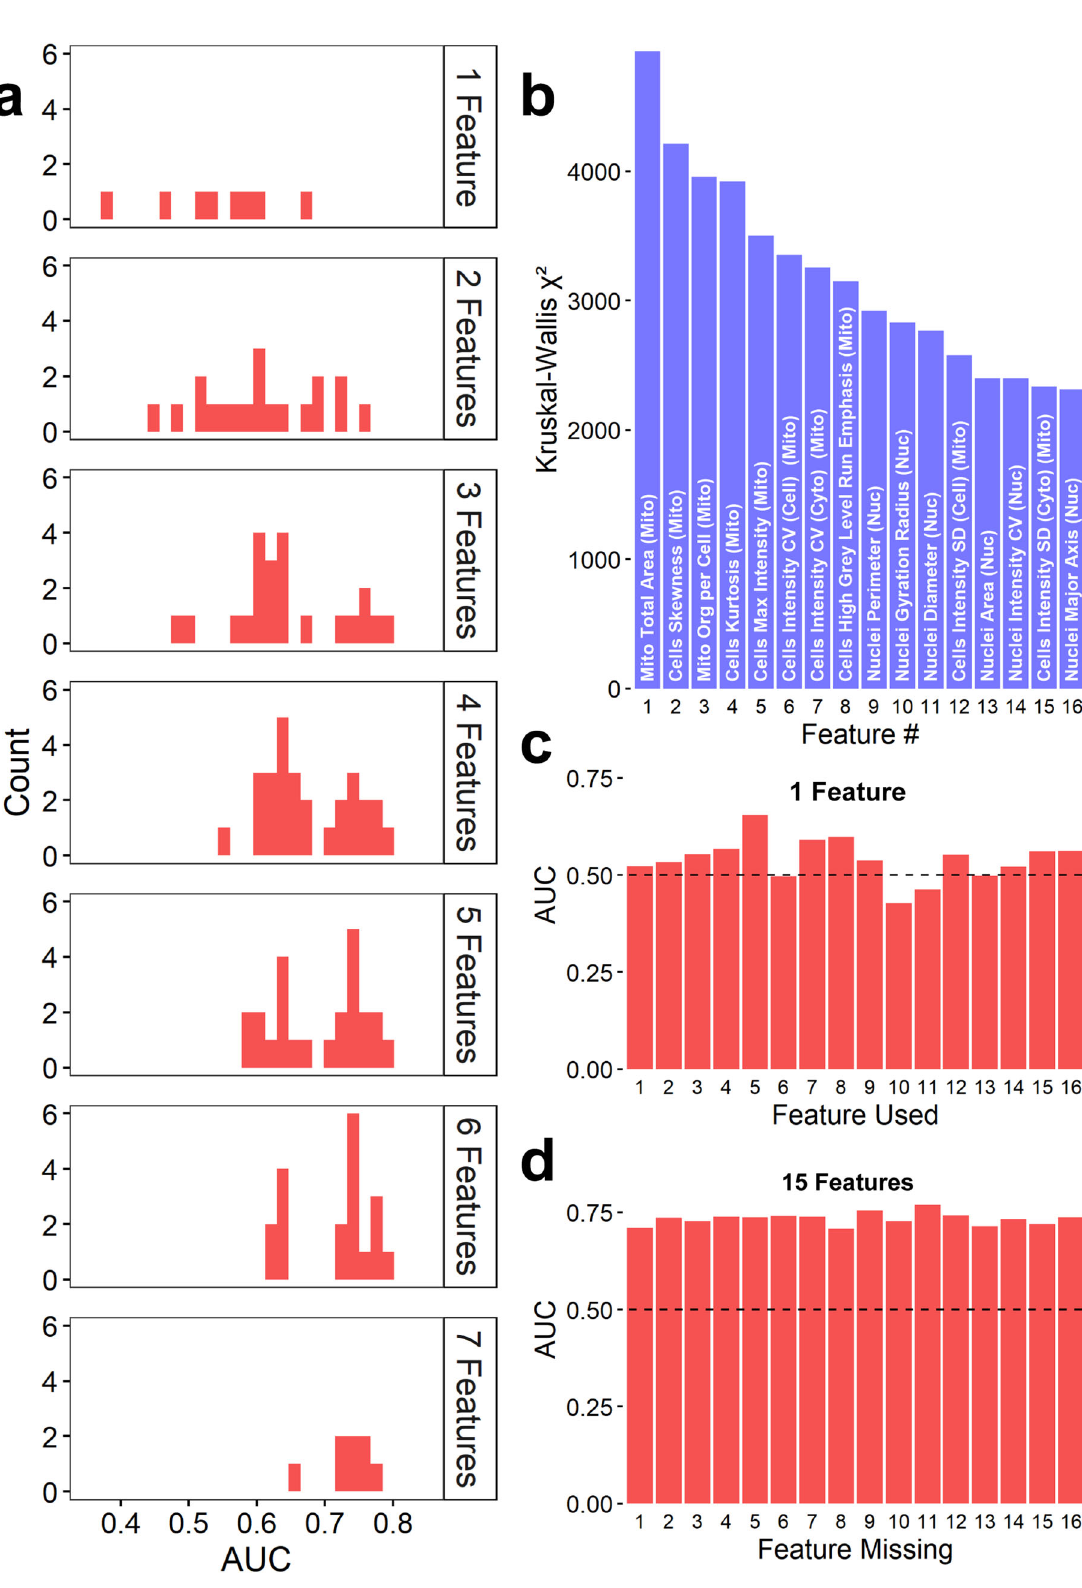
Fig. 3 MFN2 Genotype Prediction does not depend on speci fi c features. a Histograms of AUCs resulting from models built from combinations of a set of 8 features used when picking, arranged in panels split by the number of features used in each subset. b Bar chart of the Kruskall – Wallis χ 2 values for the 16 features with the highest values. “ Mito ” and “ Nuc ” indicate features measured from mitochondrial and nuclear stains, respectively. c Bar chart of the AUCs resulting from models built out of each individual feature. Note that the most signi fi cant feature was unable to produce a good model alone. d Bar charts of the AUCs resulting from models built using all but one feature (leaving 15 features). All AUCs listed indicate the performance of the model trained from labeled data on their ability to predict unlabeled cells in admixed